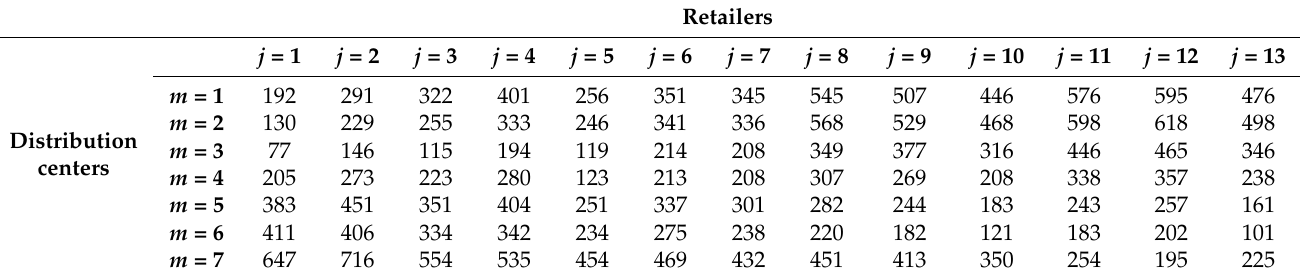
Table A3. Distances between distribution centers ( k ) and retailers ( j ) in km.